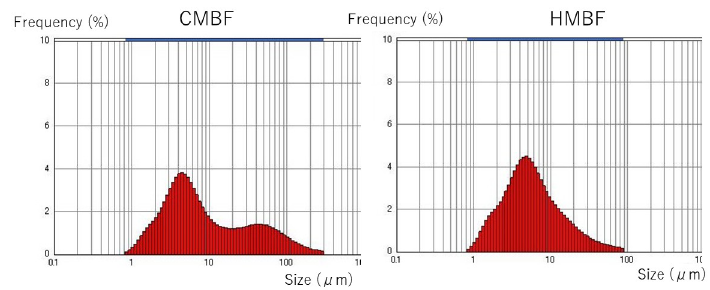
Fig 5. Distribution of particle size: 24 hours after fortification. The particle size distributions after 24 hours of fortification are shown for milk with cow milk-based fortifier (CMBF) and human milk-based fortifier (HMBF). The shape of the particle distribution after 24 hours of CMBF fortification was wider toward the end and different from the shape after 24 hours of HMBF fortification.